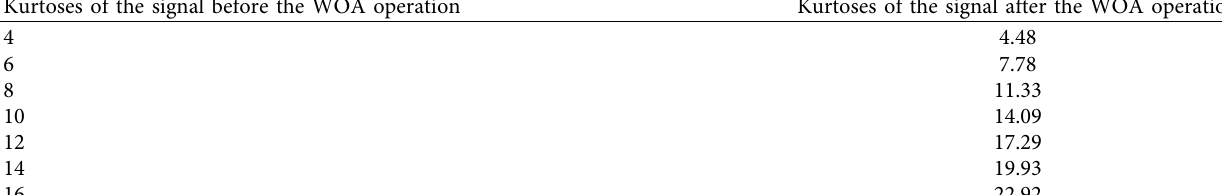
Figure 15: The kurtoses of the signal before the WOA operation (a) and the kurtoses of the signal after the WOA operation (b). Table 3: The maximum kurtoses with the signal processed by the windowed ZMNL transformation. Kurtoses of the signal before the WOA operation